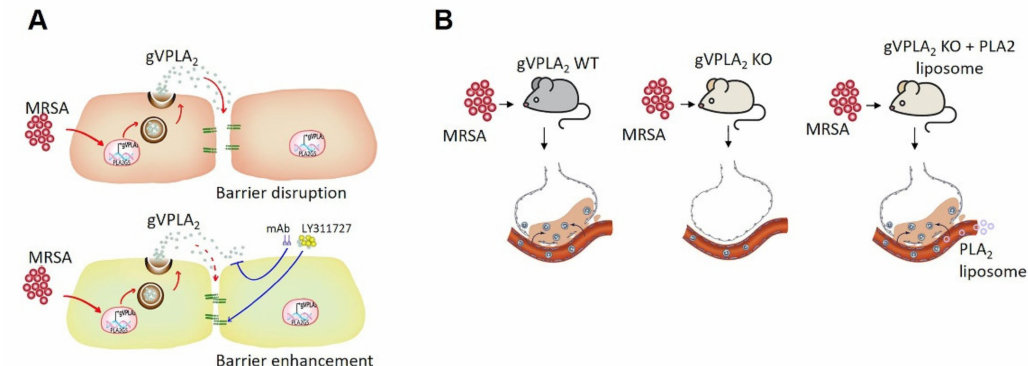
Figure 10. Overview schema of the role of gVPLA 2 in MRSA-induced ALI. ( A ): Depicted are lung endothelial cells in barrier- disrupted (top) or barrier-enhanced (bottom) conditions. In vitro studies demonstrate that MRSA increases EC permeability and expression of gVPLA 2 . Inhibition of gVPLA 2 using the inhibitor LY311727 or a monoclonal blocking antibody against gVPLA 2 (MCL-3G1) attenuates MRSA-induced lung EC permeability and enhances barrier function. ( B ): Depicted are mice and alveolar-capillary units with or without pulmonary edema and neutrophil infiltrates. In vivo studies demonstrate that MRSA-induced lung injury is attenuated in gVPLA 2 KO mice (white) compared to WT (gray). However, restoration of endothelial gVPLA 2 expression in gVPLA 2 KO mice by administration of ACE-conjugated liposomes containing gVPLA 2 plasmid reverses the protective effects observed in these mice after